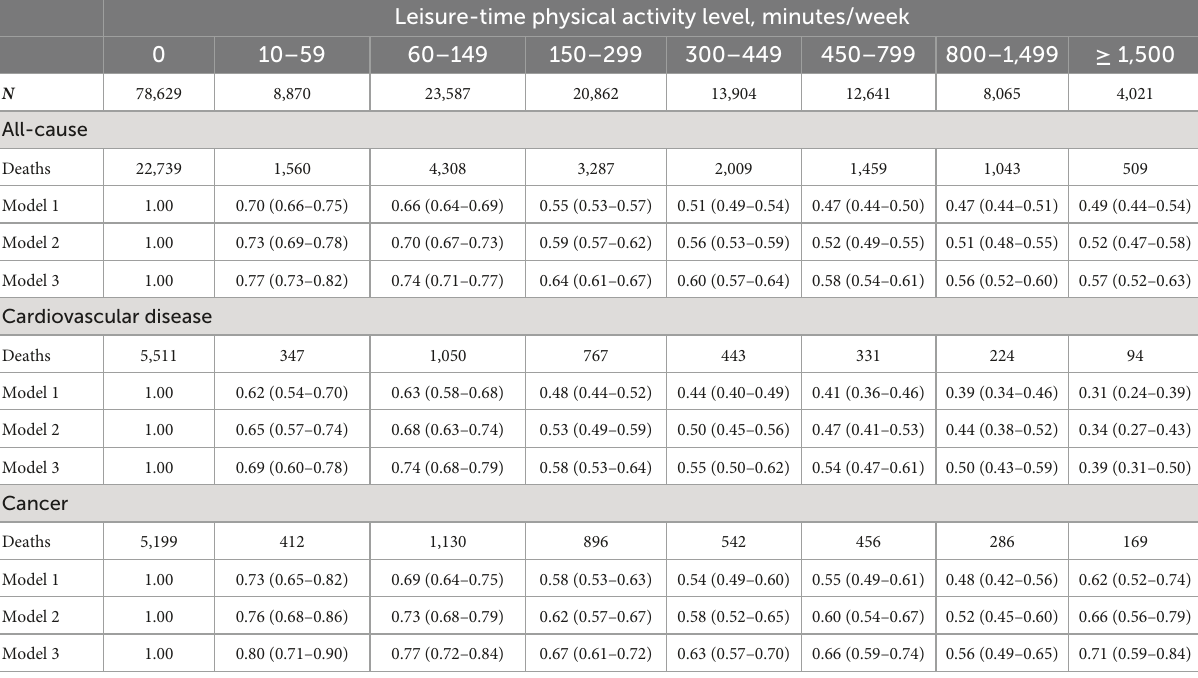
Dataarepresentedashazardratios(95%confidenceintervals). Model1:Adjustedforsex,age,andrace/ethnicity. Model2:Model1+educationandmaritalstatus. Model3:Model2+bodymassindex,smoking,alcoholintake,numberofchronicdiseases,andmuscle-strengtheningactivity.